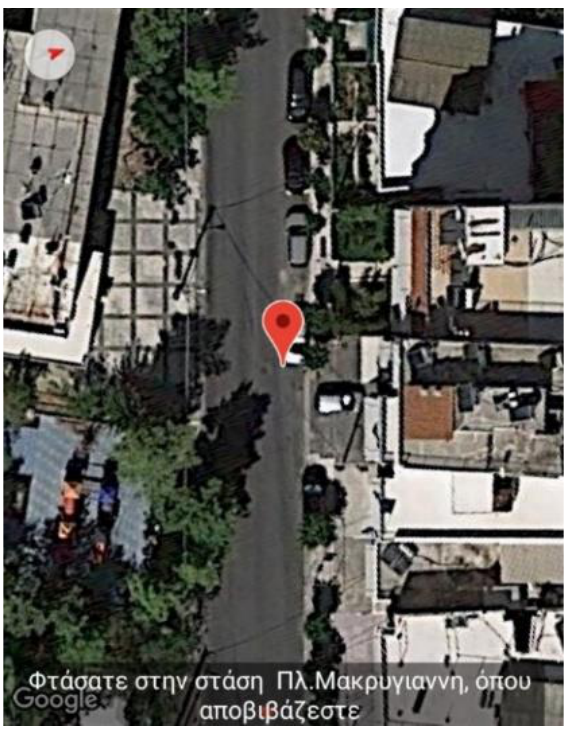
Figure 7. The application issues the instruction “You reached Makrygianni Square stop—Exit the bus”.